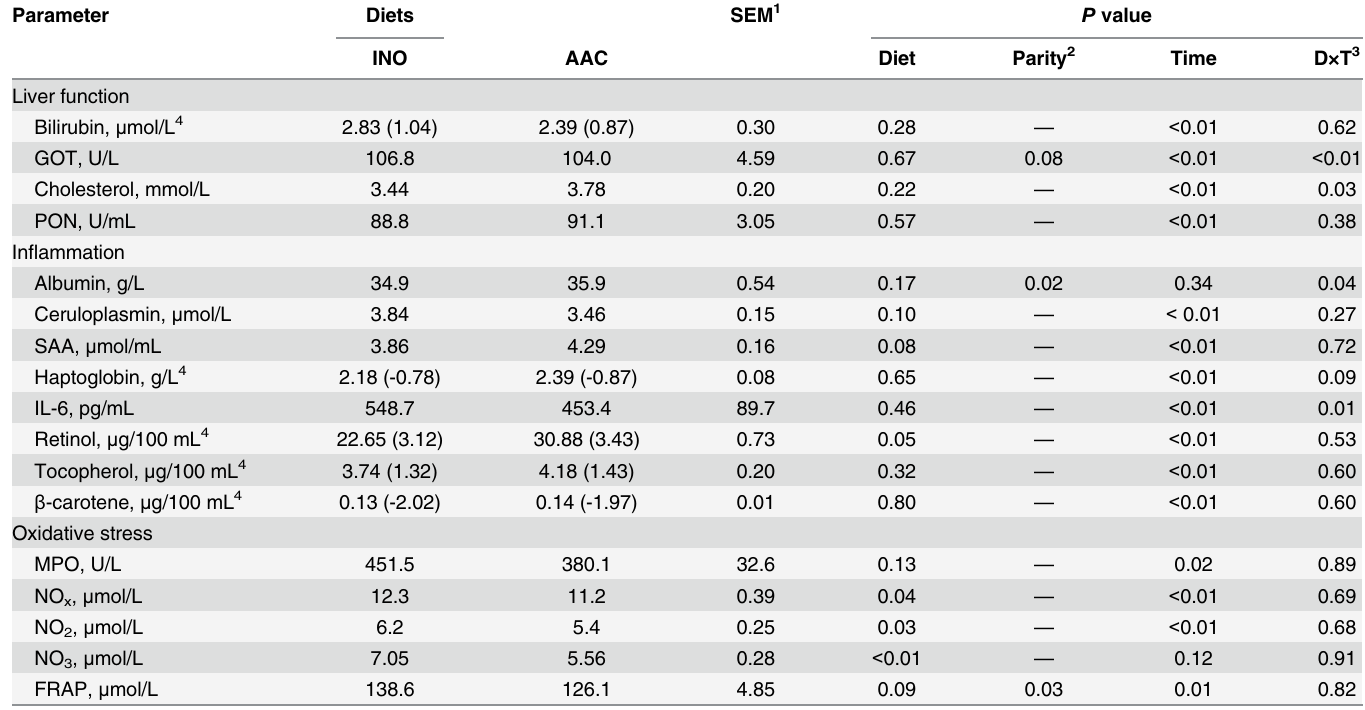
Table 1. Effects of supplementing cows with inorganic (INO) or organic (AAC) trace minerals during the peripartal period on blood biomarkers of liver function, inflammation and oxidative stress.